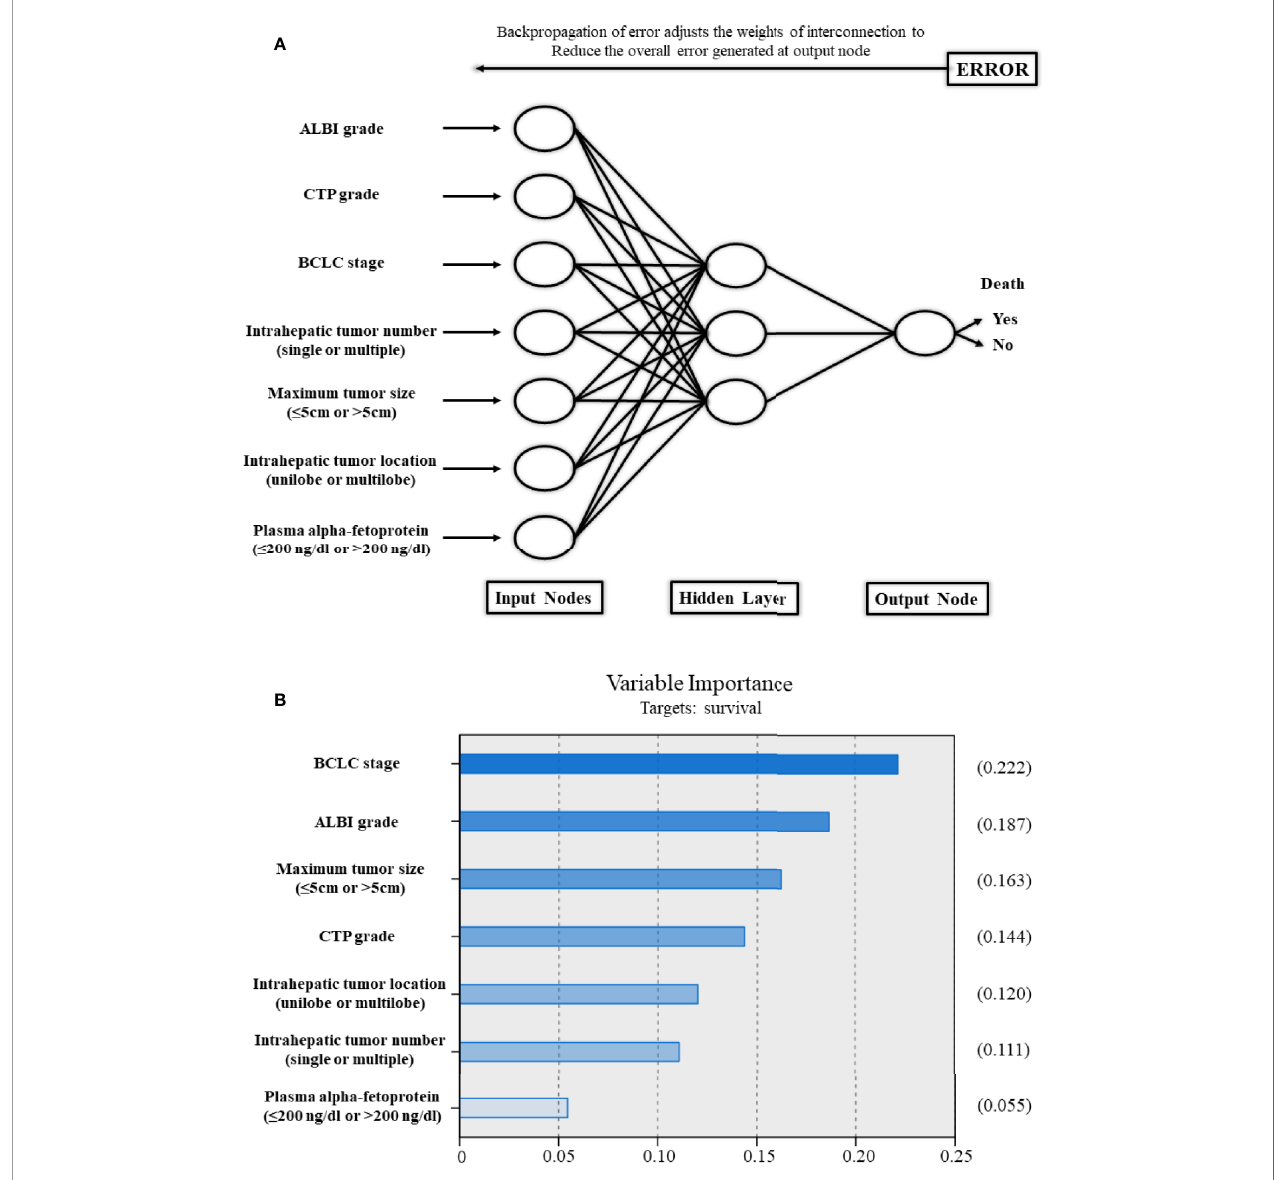
FIGURE 5 | (A) Schematic representation of the arti fi cial neural network developed to predict survival for patients with hepatocellular carcinoma after transarterial chemoembolization combined with sorafenib. (B) The importance of each variable in the arti fi cial neural network model. ALBI, albumin-bilirubin; CTP, Child – Turcotte – Pugh; BCLC, Barcelona Clinic Liver